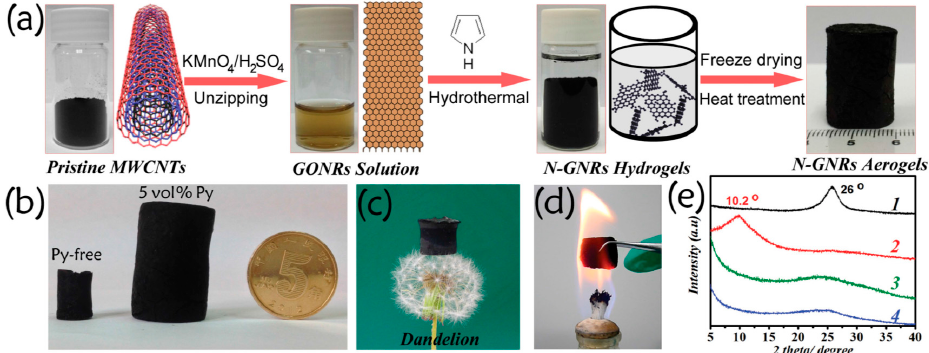
Figure 5. ( a ) Illustration of the synthesis for N-GNRs-A; ( b ) photographs of fabricated 3D graphene nanoribbon aerogels derived without (left) or with (middle) 5 vol % Py GONRs suspension (10 mg ∙ mL − 1 ) under hydrothermal treatment. Photograph of ultralight N-GNRs-A standing on a dandelion ( c ) and in a hot flame of an alcohol burner ( d ); and ( e ) XRD patterns of (1) pristine MWCNTs, (2) GONRs, (3) GNRs-A, and (4) N-GNRs-A. Reprinted with permission from